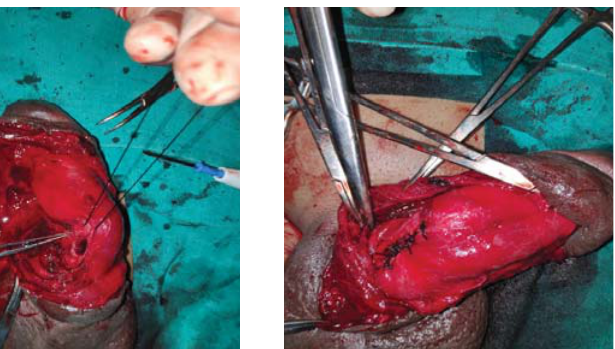
Figure 4. Repair of tunica albuginea with 3-0 polyglactin